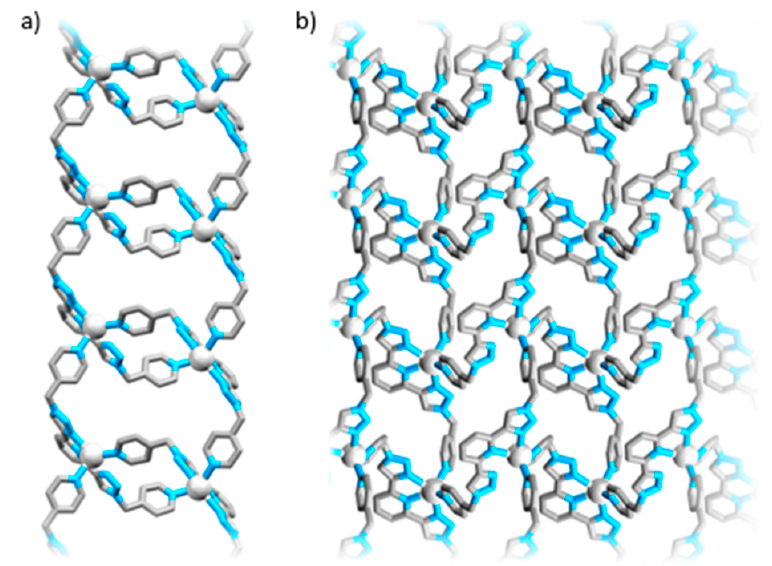
Figure 5. Solid state structure of [Ag( L )]SbF 6 showing linear chains of macrocycles ( a ) and the extended structure ( b ). Selected bond lengths (Å): Ag1-N9 = 2.26, Ag1-N13 = 2.43, Ag1-N10 = 2.33, Ag1-N14 = 2.45, Ag1-N15 = 2.72. Color scheme: carbon, grey; nitrogen, blue; silver, silver. Hydrogen atoms, solvent molecules and SbF 6 − counter anions were omitted for clarity.